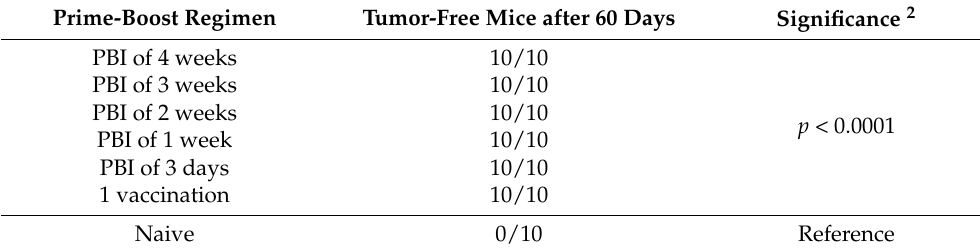
Table 1. Survival of mice receiving different prime-boost regimens 1 . Prime-Boost Regimen